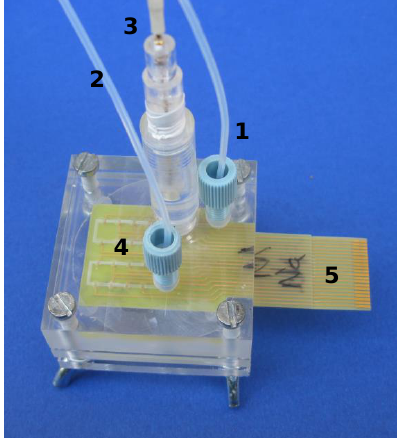
Figure 7. An electronic tongue system with integrated sensing matrix applied for an off-line analysis of cell cultures. 1. inlet, 2. outlet, 3. reference electrode, 4. integrated sensor matrix, 5. electrical connections (reprinted with permission from [140] © Elsevier).